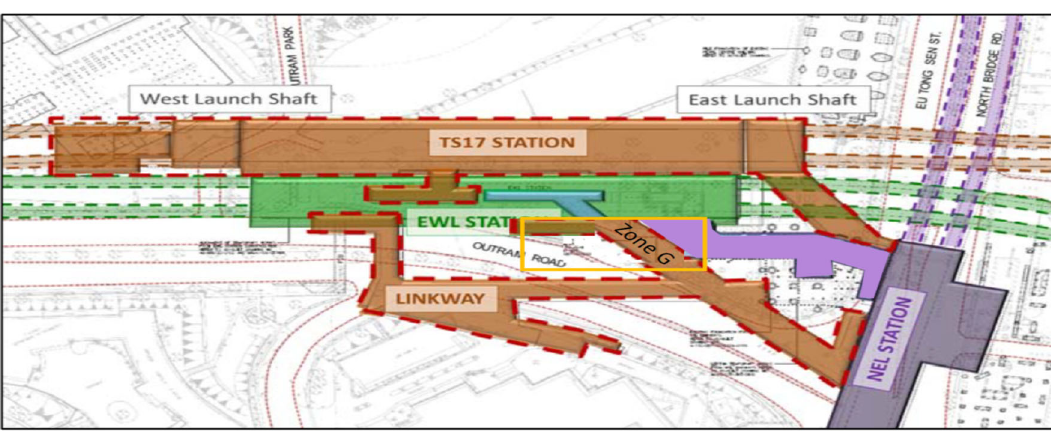
Fig. 2 Location of zone